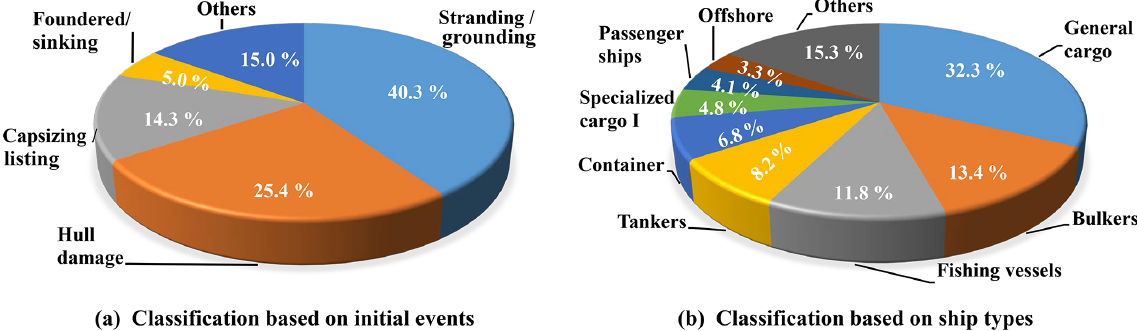
Figure 1. Classification of the 755 weather-related ship accidents based on initial events (a) and ship type (b) . The accidents were recorded in the International Maritime Organization (IMO)